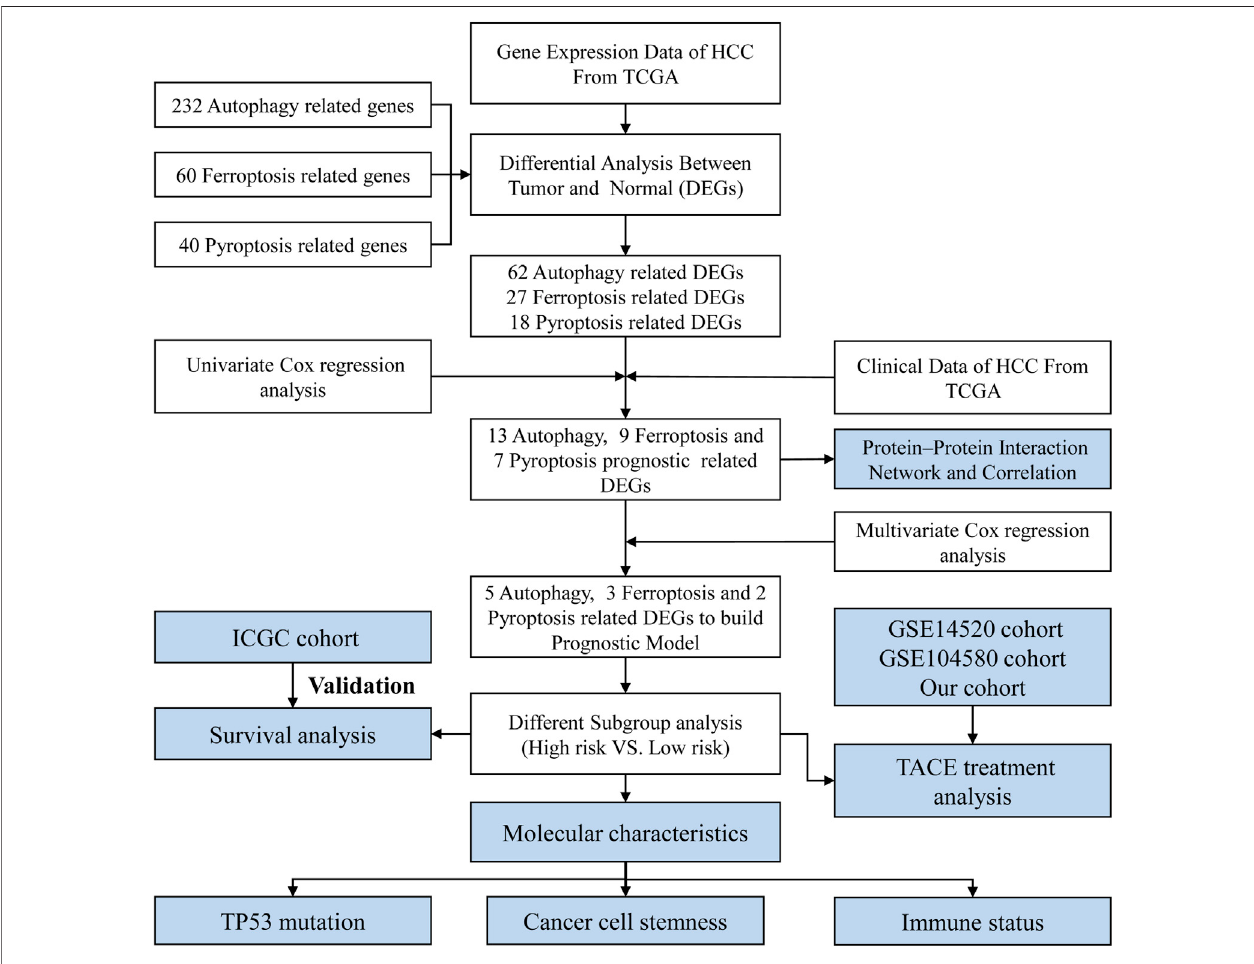
FIGURE 1 | Flow chart of data collection and